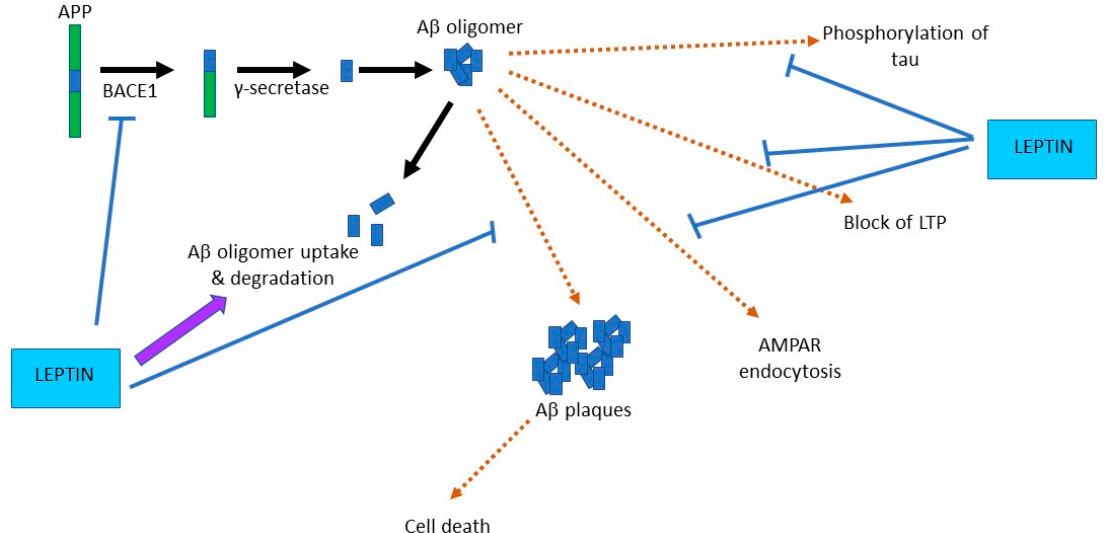
Figure 3. Leptin prevents the aberrant toxic effects of β -amyloid (A β ) at synapses. Cleavage of amyloid precursor protein (APP) by the sequential actions of Beta secretase-1 (BACE1) and γ -secretase generates A β protein that readily aggregates into oligomeric forms of A β . Acute exposure to A β oligomers promotes toxic actions at synapses that include tau phosphorylation, AMPA receptor endocytosis, and block of hippocampal LTP. Chronic exposure to A β leads to plaque formation and enhanced cell death. Leptin prevents the acute effects of A β on synaptic function, and it limits A β production and overall brain load, by reducing BACE1 activity, and promoting degradation of A β .